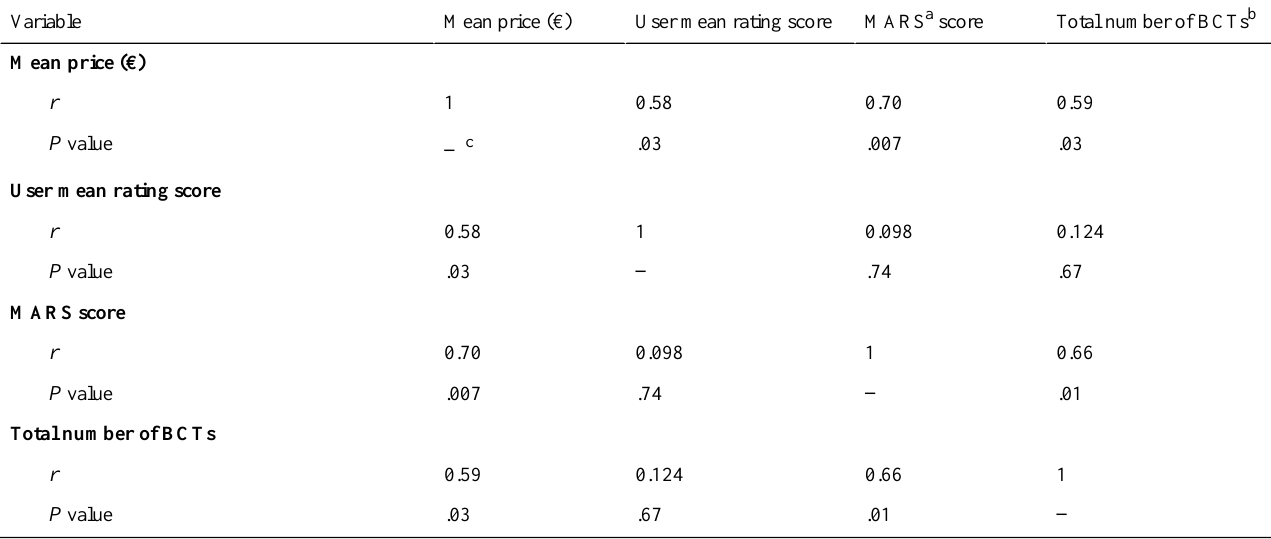
Table 4. Correlations among the total Mobile App Rating Scale (MARS) score, price, user rating, and number of behavioral and cognitive